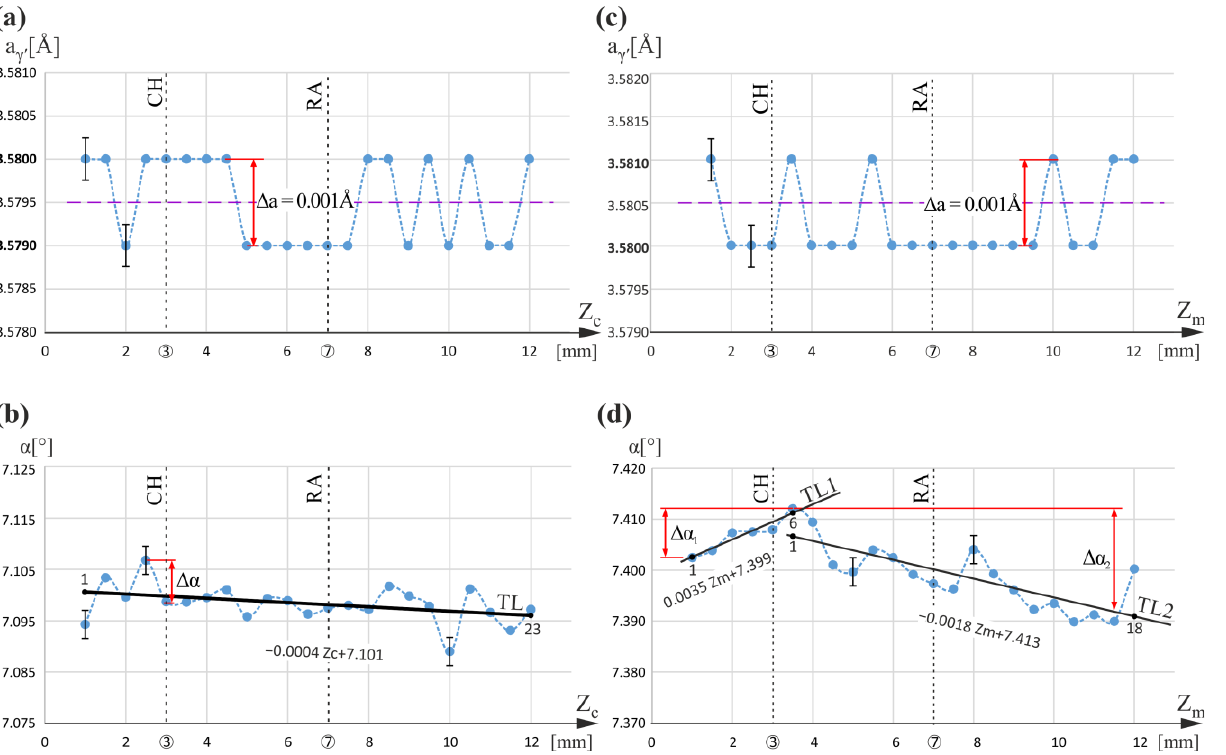
Figure 2. Graphs of the a γ′ (Z c ) and α(Z c ) relationships obtained for measurement line c ( a , b ) and graphs of the a γ′ (Z m ) and α(Z m ) relationships obtained for measurement line m ( c , d ). Z c and Z m are parallel to Z.